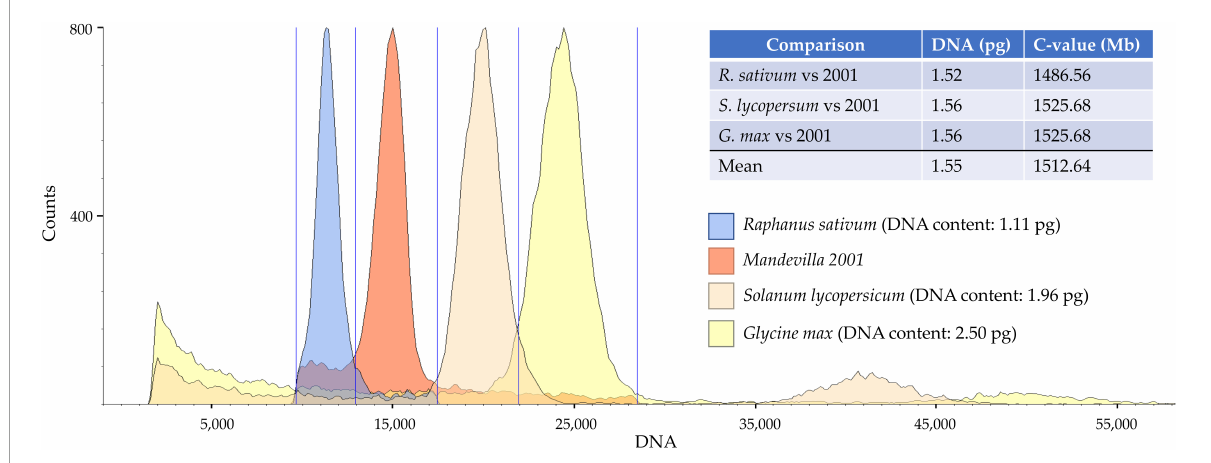
FIGURE1 Flow cytometry analysis for genome size estimates. Each peak represents the total DNA fluorescence emission of propidium iodide (PI)-stained leaf nuclei purified (in order from left to right) from Raphanus sativum , Mandevilla 2001, Solanum lycopersicum , Glycine max.